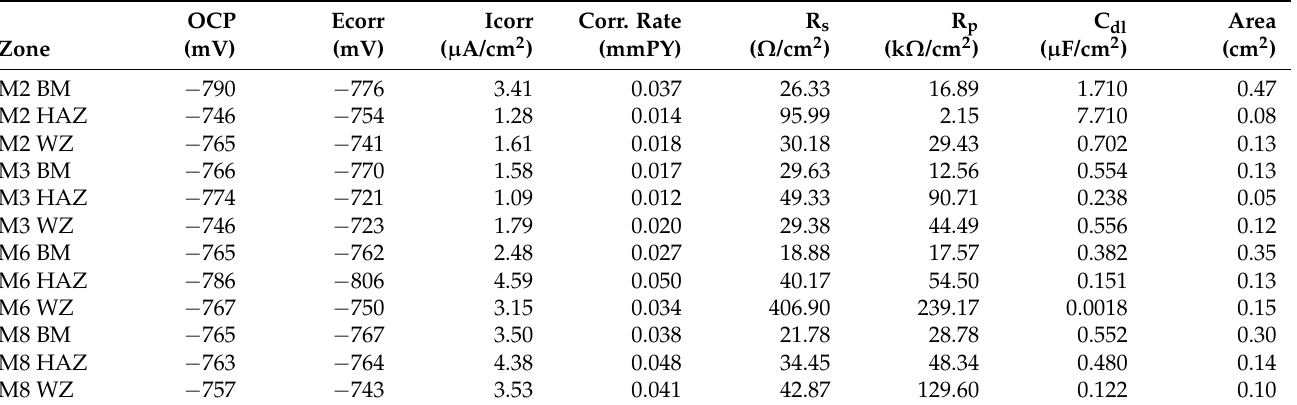
Table 7. Corrosion results for open-circuit potential, potentiodynamic polarization, and electrochemi- cal impedance spectroscopy for selected